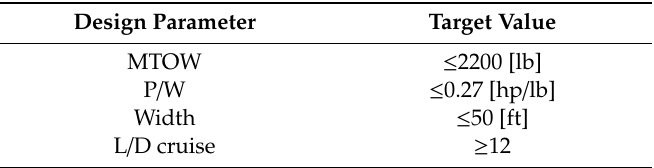
Table 13. Objective design parameters and objective